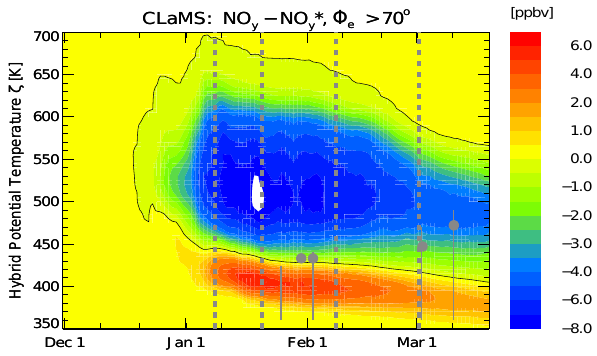
Fig. 10. Simulated NO y redistribution from CLaMS HR run de- rived as the difference of simulated NO y and the passive tracer NO ∗ y averaged inside the polar vortex core (equivalent latitudes > 70 ◦ N). Thick grey lines indicate dates for which comparisons with ACE-FTS were performed as shown in Fig. 12. Comparisons with SIOUX on Geophysica shown in Figs. 13 and 14 are marked as grey dots and thin grey vertical lines, respectively.